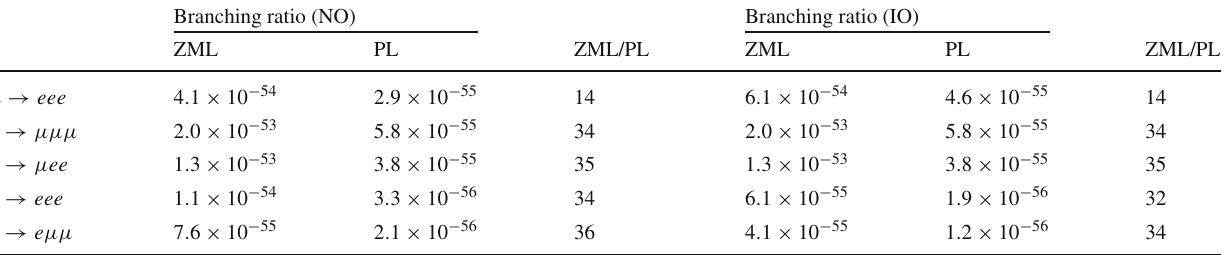
Fig. 1 One-loop diagrams contributing to the CLFV decay L − → (cid:3) − (cid:3) (cid:3)+ (cid:3) (cid:3)− in the unitary gauge: the Z penguins ( a , b ), the photon penguin ( c ) and the box ( d ). Wave function corrections (not depicted here) must be included as well Table 1 Branching ratio for the CLFV decays L → (cid:3)(cid:3) (cid:3) (cid:3) (cid:3) in the ZML and the PL for normal ordering (NO) and inverted ordering (IO) of neutrino masses. The ratio between the two is also reported. In the ZML we assume m 1 = 0 (NO) or m 3 = 0